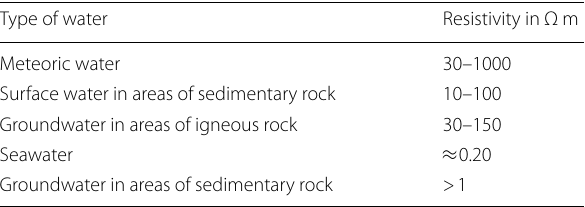
Table 1 Resistivity of various types of water (Saad et al.